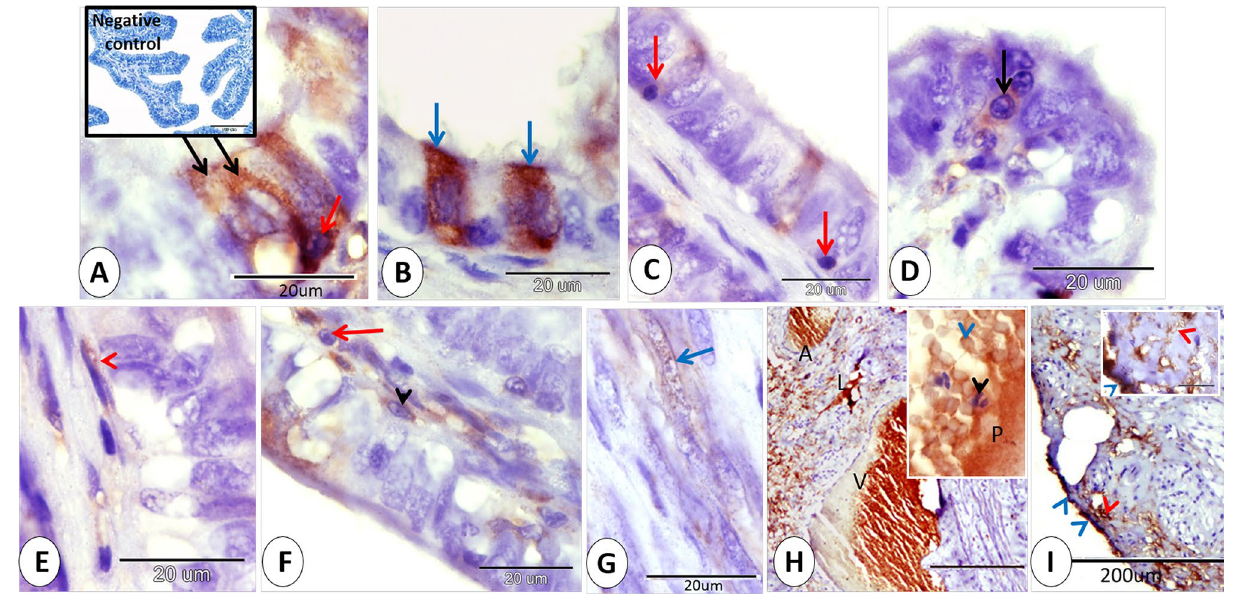
Figure 1. Immunohistochemical localization of ERA in rabbit cervix at 0 day of pregnancy. ( A ) Secretory cells (black arrows) show moderate cytoplasmic and moderate nuclear immunostaining for ERA and Intraepithelial lymphocytes show strong immunostaining for ERA (red arrow). ( B ) Ciliated cells (blue arrows) show moderate cytoplasmic and moderate nuclear immunostaining for ERA. ( C ) Intraepithelial lymphocytes (red arrows) show mild immunostaining for ERA. ( D ) Intraepithelial lymphocytes (black arrows) show moderate immunostaining for ERA. ( E ) Subepithelial telocytes (red arrowhead) show moderate cytoplasmic and negative nuclear immunostaining for ERA. ( F ) fibroblasts (black arrowhead) and lymphocytes (red arrow) showed mild cytoplasmic and negative nuclear ERA immunostaining. ( G ) Smooth muscle fibers (blue arrow) show mild cytoplasmic and mild nuclear immunostaining for ERA. ( H ) the blood plasma (P), red blood cell (blue arrowhead) and cytoplasm of leukocyte (black arrowhead) within the arteries (A) and veins (V) demonstrated moderate immunoreactivity to ERA. Lymph within lymphatic vessels (L) showed strong immunoreactivity to ERA. ( I ) Serosal interstitium (red arrowheads), and mesothelium (blue arrowheads) showed moderate and strong ERA immunostaining. Note, bordered area in ( A ) the negative